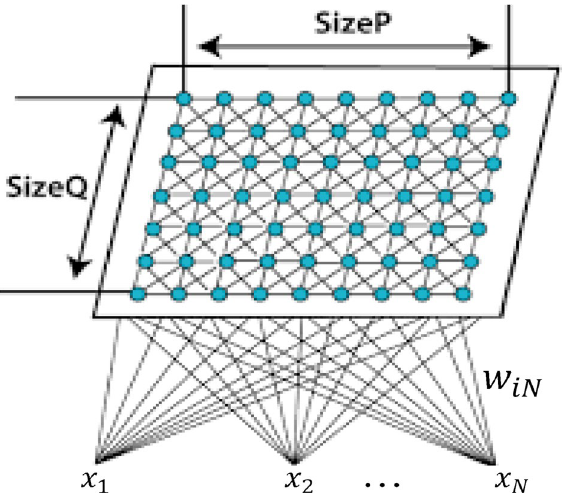
Figure 13. SOM showing the map topology and interactions between nodes. Each neuron is assigned a vector of weights ( w = w i 1 , w i 2 , . . . w iN ) with dimension similar to the input vector i ( i = 1, 2, . . . , L ); where L is the total number of neurons in the network. The input nodes have p features, and the output nodes, q prototypes, with each prototype connected to all features. The weight vector of the connections consumes the prototype of each neuron and has same dimension as the input vector. SOMs differ from other artificial neural networks as they apply competitive learning, against error correction learning such as backpropagation, and the fact that they preserve the topological properties of the input space using a neighborhood